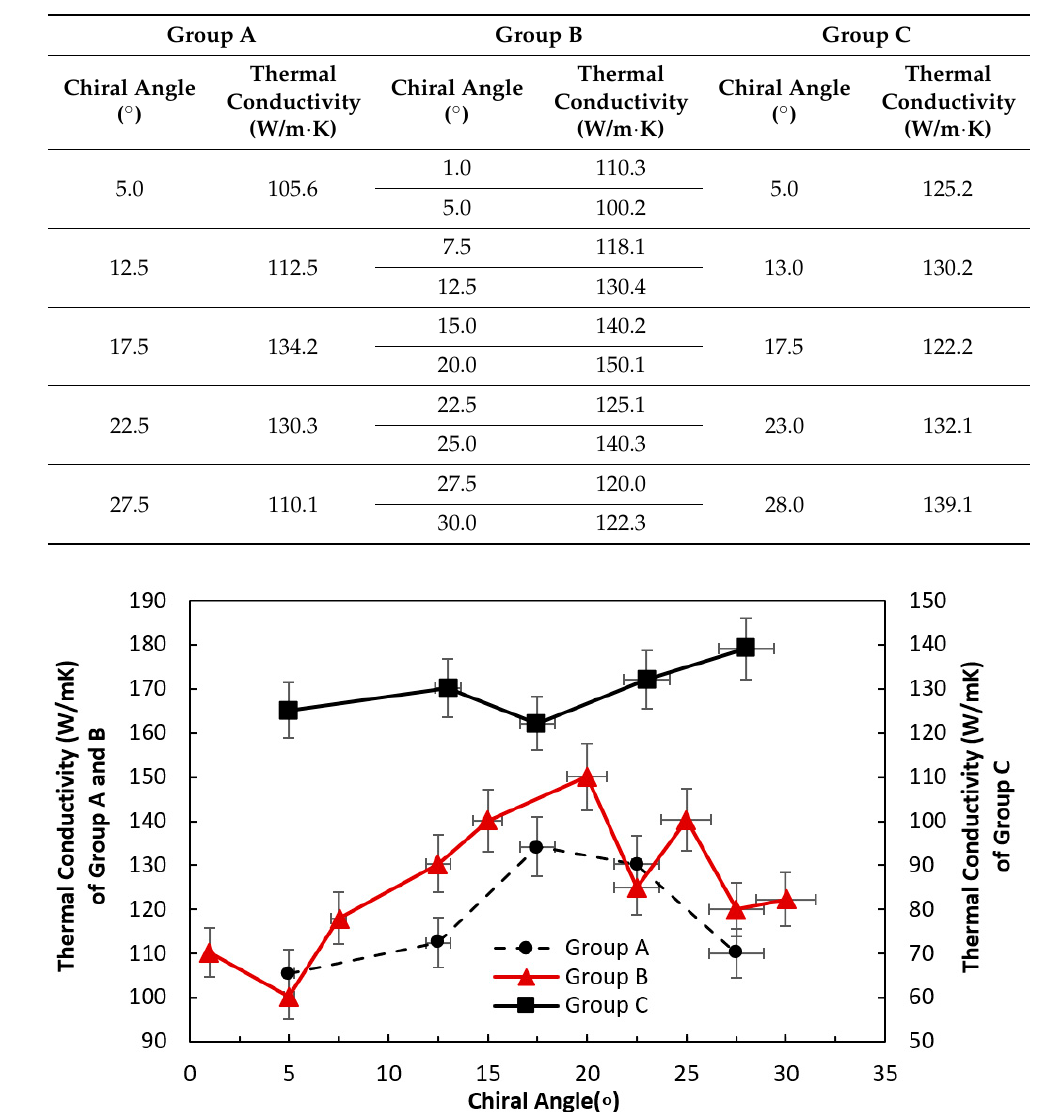
Table 1. Chiral angle-dependent thermal conductivities of group A, B and C of SWNTs [46,62–68].